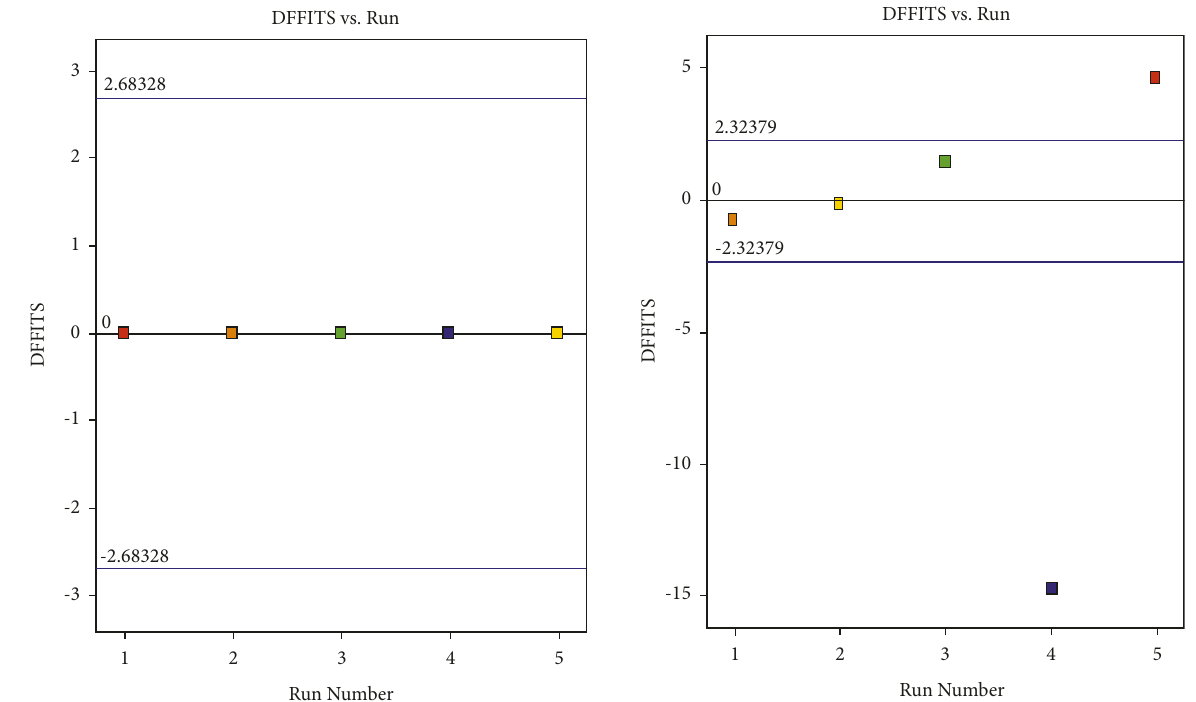
Figure 15: Diagnostic influence plot of DFFITS vs. experimental